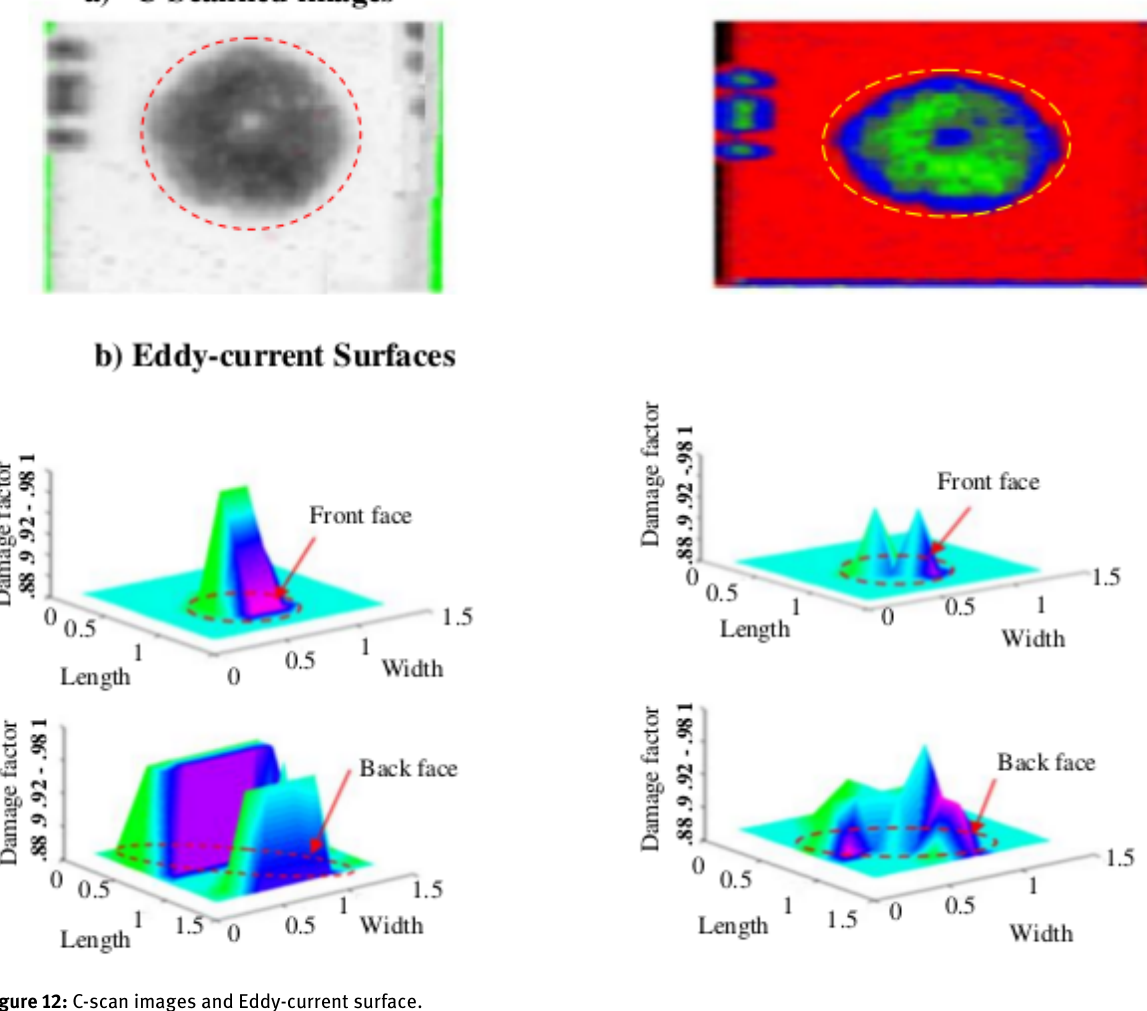
Figure 12: C-scan images and Eddy-current